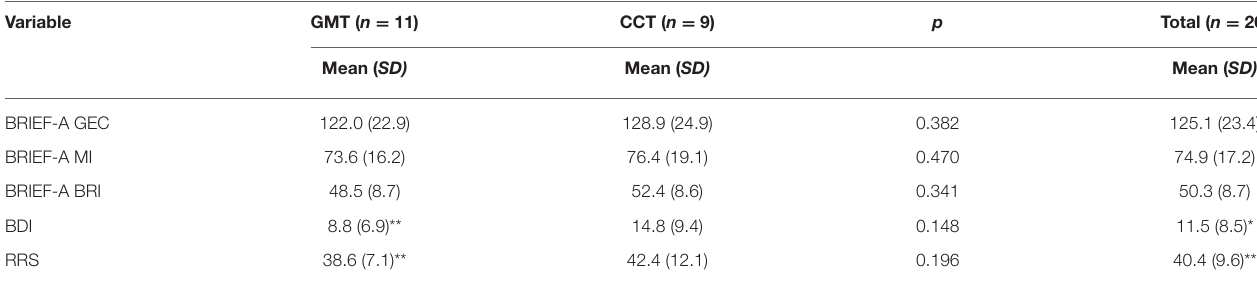
TABLE 2 | Two-year follow-up outcomes for GMT, CCT, and the whole sample.